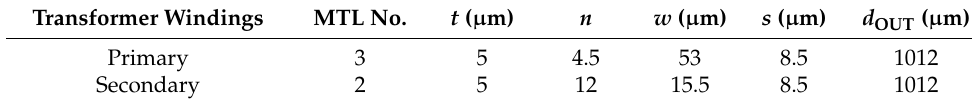
Table 2. Geometrical parameters of the polyimide isolation transformer.